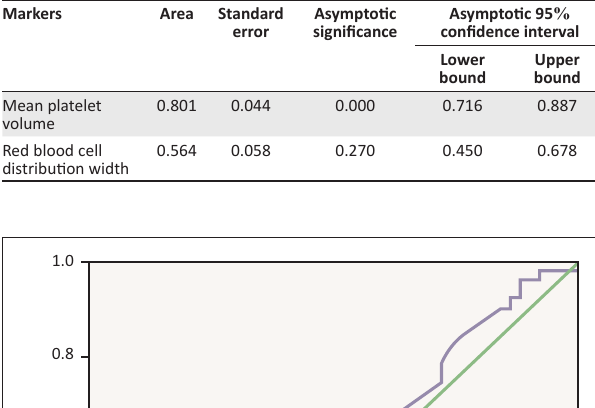
TABLE 2: Receiver operating characteristic curves for comparison of mean platelet volume and red blood cell distribution width utility in discriminating between healthy controls and IBS patients, Babol, Iran,